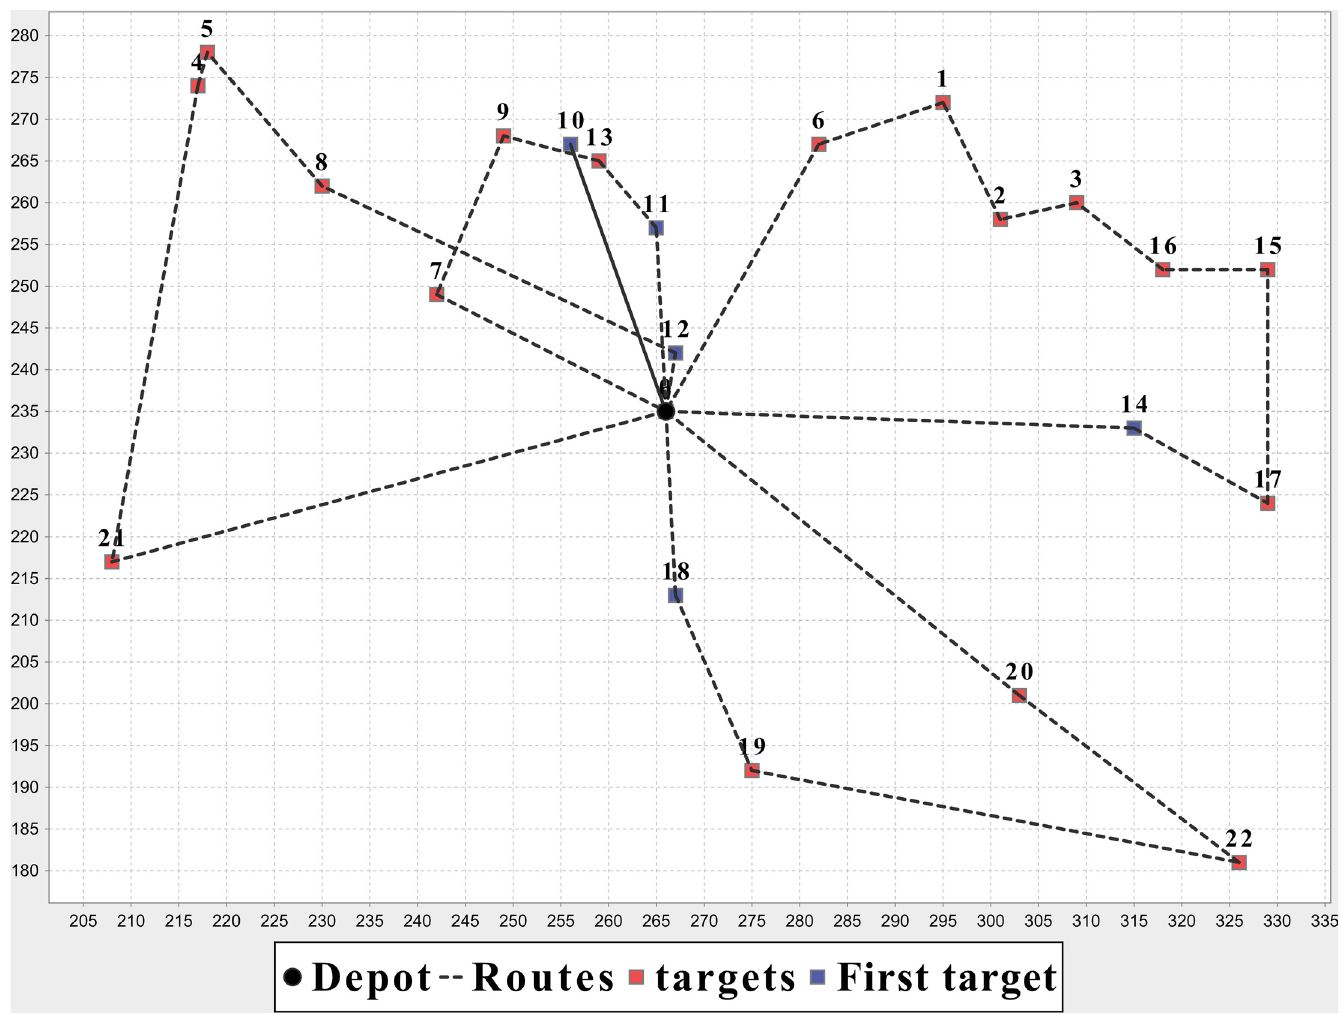
Fig 12. Optimization results of MOEA/D-N-UAV on instance E-n23-k3.